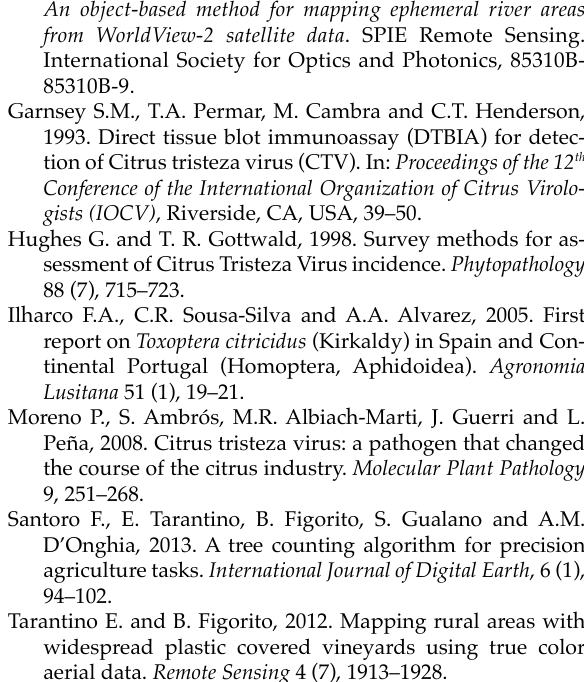
Figorito B., E. Tarantino, G. Balacco and U. Fratino,